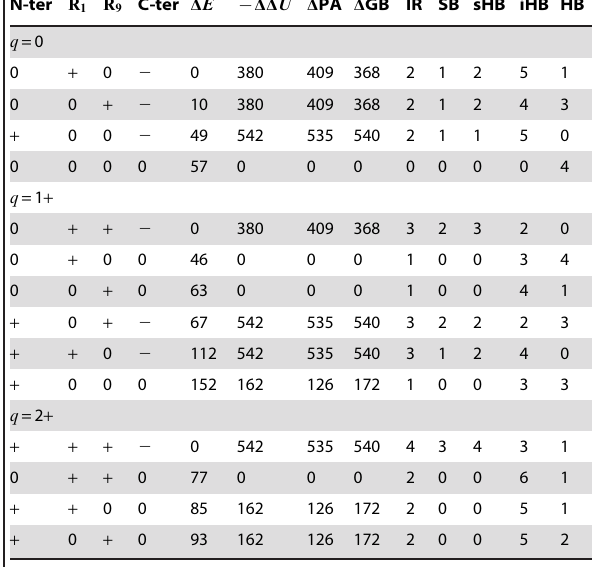
Table 1. Energetics and structural parameters for the lowest- energy conformers of bradykinin